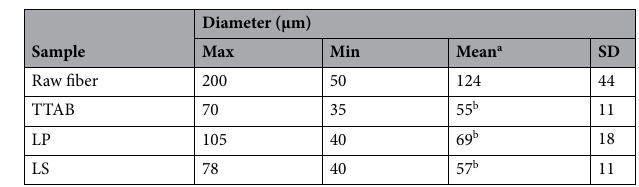
Table 1. Diameters of the raw and the treated cellulose fiber bundles. a Averaged over 60 fiber bundles diameter determination on the full data set coming from the same softener at room temperature (irrespective of concentration and time). b Mean value significantly different with respect to that of the raw fiber at the 0.01 level (one-way ANOVA